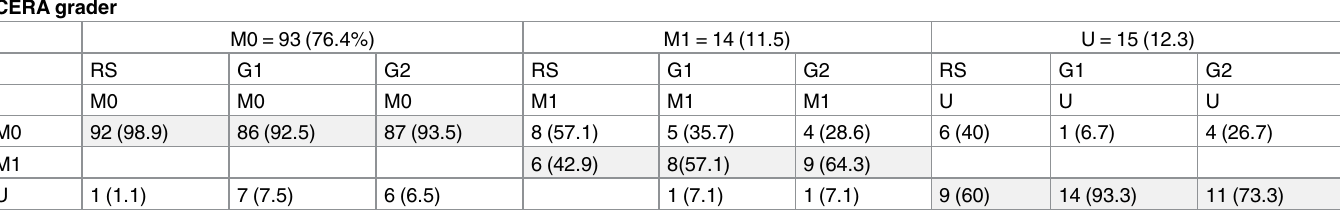
Table 5. Comparison of maculopathy graded by the CERA grader, retinal specialist and the local graders before training through the test set. CERA grader